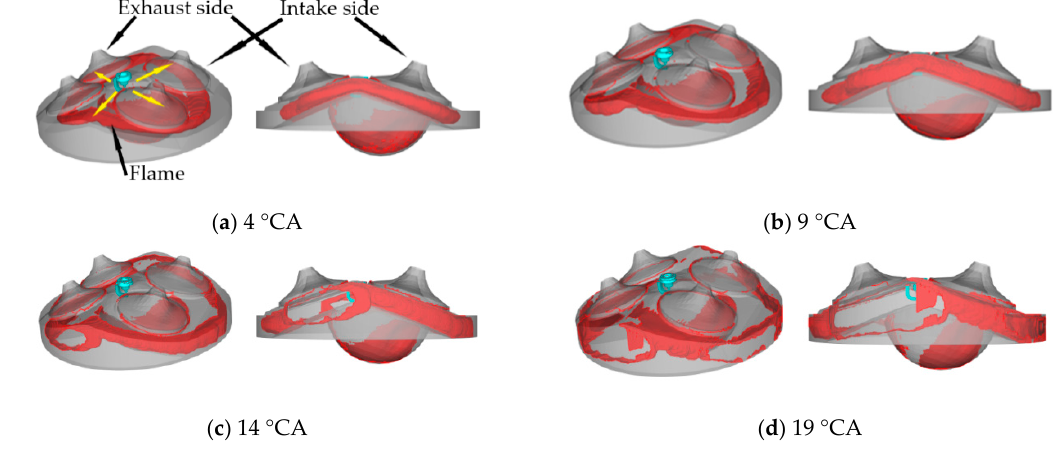
Figure 10. Flame propagation of normal combustion (Intake port on the right).